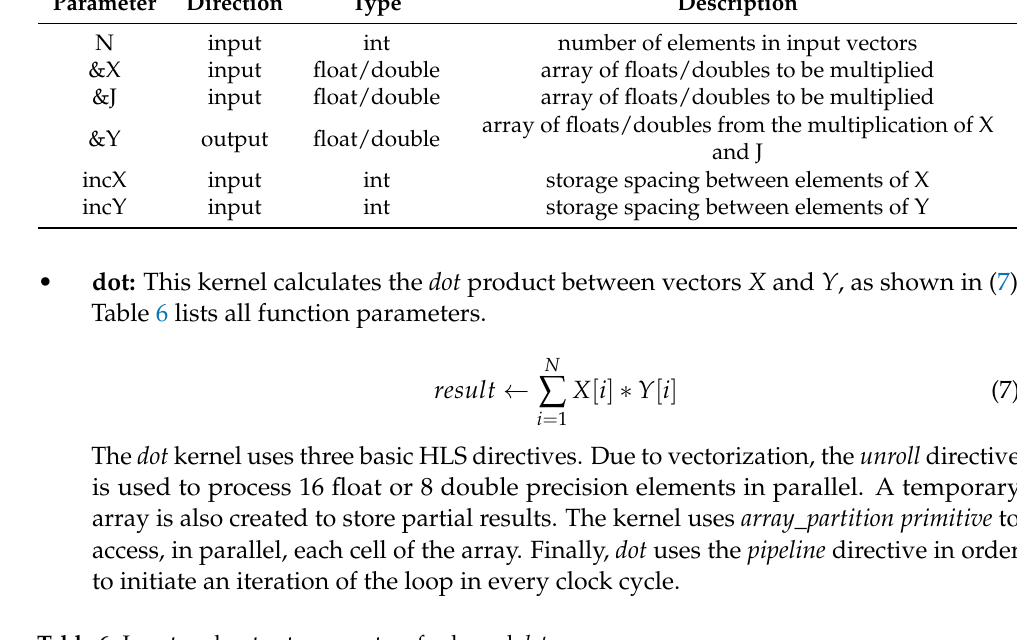
Table 6. Input and output parameters for kernel dot